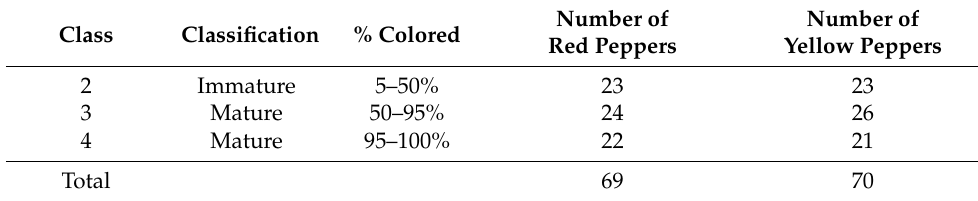
Table 1. Yellow and red sweet peppers used in the experiments.